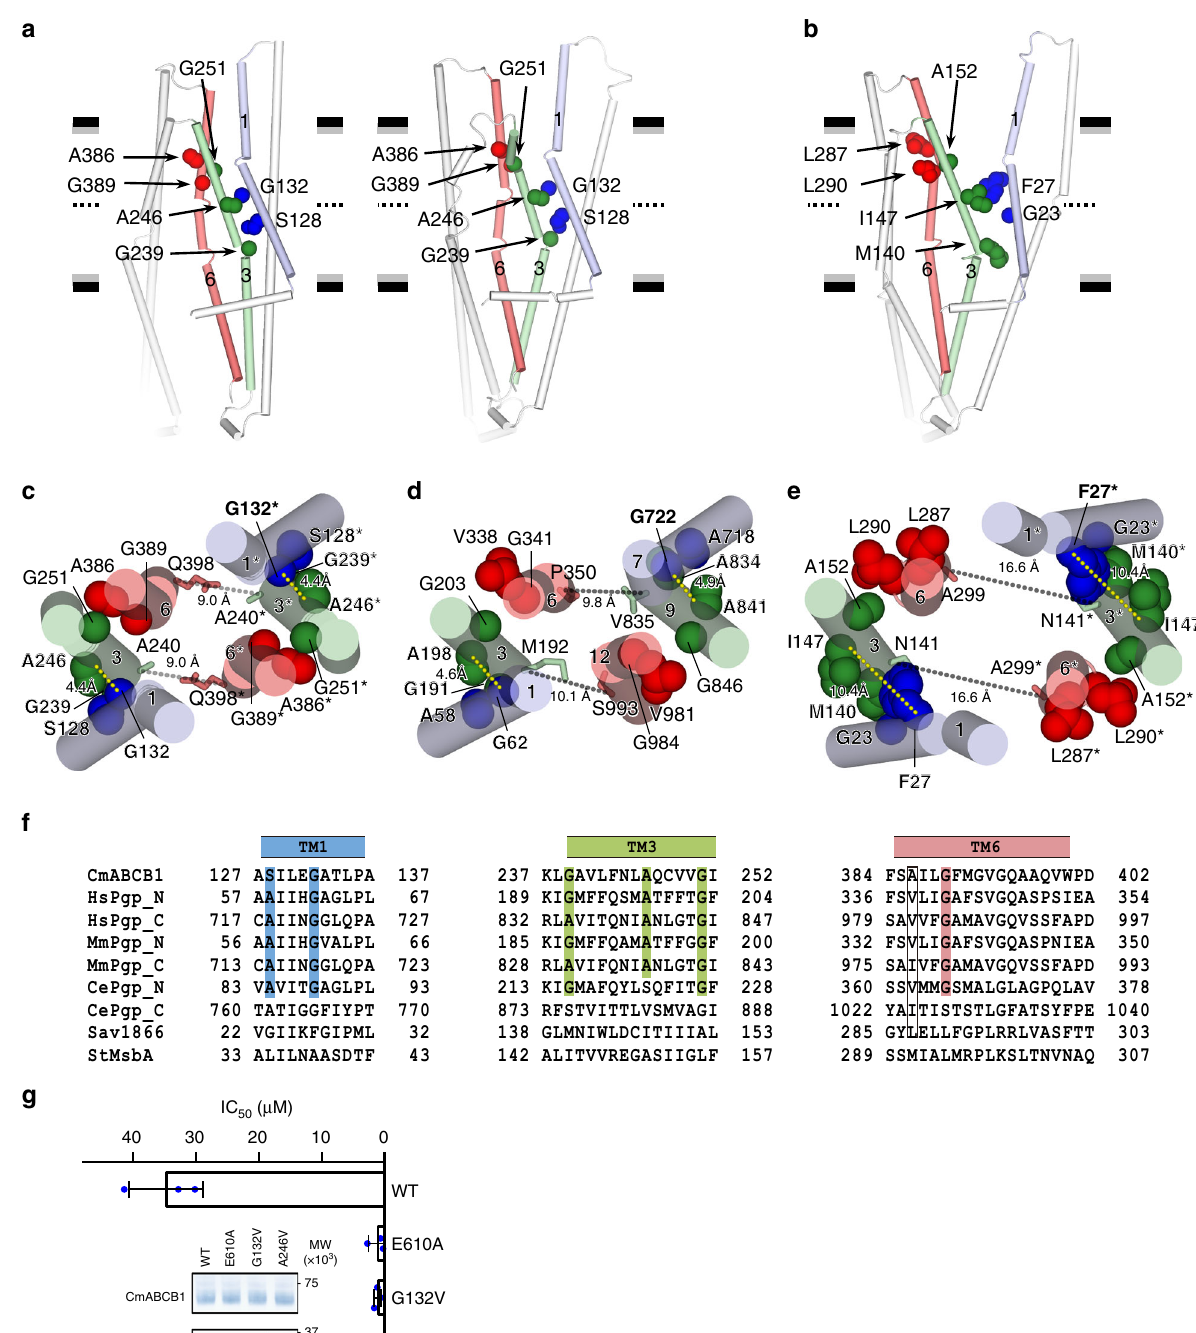
Fig. 4 TM joints characterizing the outward-facing structure of P-gp. a , b Inter-helical interactions of TM1 − TM3 and TM3 − TM6 of inward- ( a , left) and outward-facing ( a , right) conformations of QTA CmABCB1, and comparison with outward-facing structure of Sav1866 ( b ). Residues serving as TM joints in CmABCB1 and corresponding residues in Sav1866 are shown as spheres. Only the TMD of one subunit is shown for simplicity. c – e Arrangement of TM joints of outward-facing QTA CmABCB1 ( c ) and human P-gp ( d ) viewed from the extracellular side and comparison with Sav1866 ( e ). TM1 (TM1* or TM7), TM3 (TM3* or TM9), and TM6 (TM6* or TM12) are shown as cylinders. Residues serving as TM joints in CmABCB1 and the corresponding residues in human P-gp and Sav1866 are shown as spheres. f Local sequence alignment of the TM joints consisting of TM1, TM3, and TM6. Conserved Gly and other residues with small side chains, such as Ala, and Ser, are highlighted. g Bar graph, overlaid with the actual data points, shows IC 50 for growth inhibition in rhodamine 6G susceptibility assay using S. cerevisiae AD1-8u − cells. Error bars indicate standard deviation ( n = 3). Cells expressing the ATPase-de fi cient mutant E610A served as controls. Inset shows the amounts of mutant and WT CmABCB1 expressed in AD1-8u − cells, as determined and analyzed by western blotting. Uncropped images of the blots are shown in Supplementary Fig.